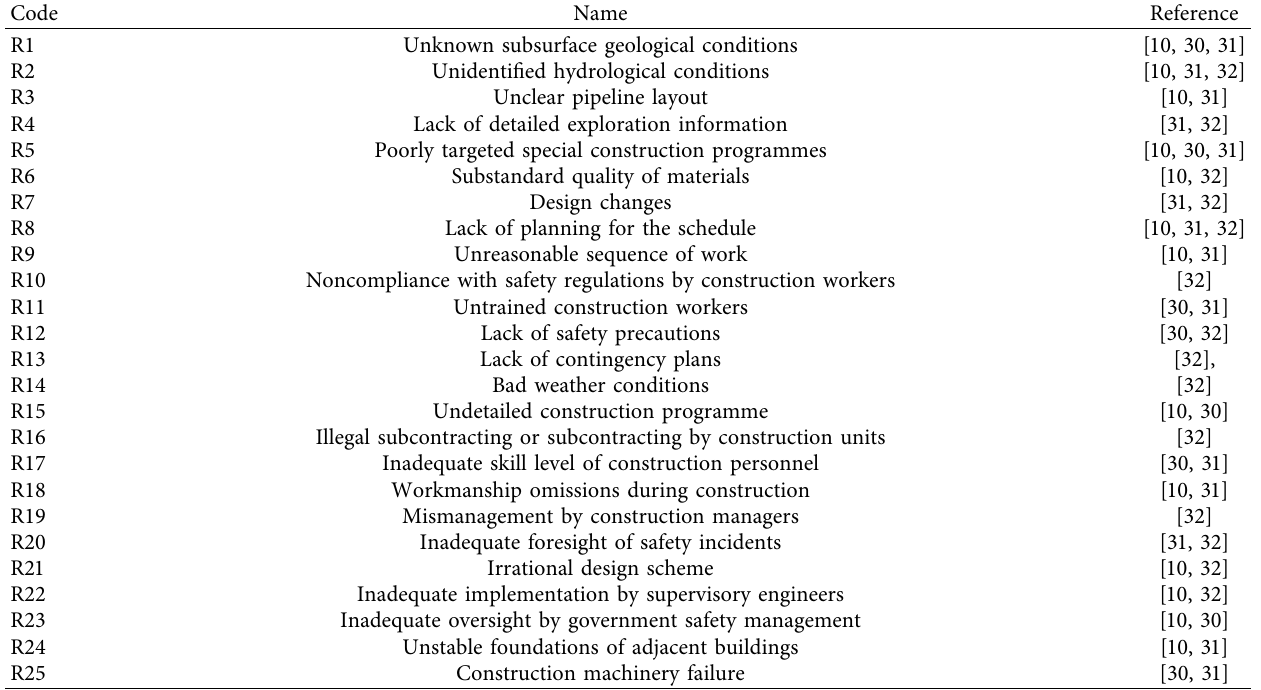
Table 4: Identification of safety risk factors.